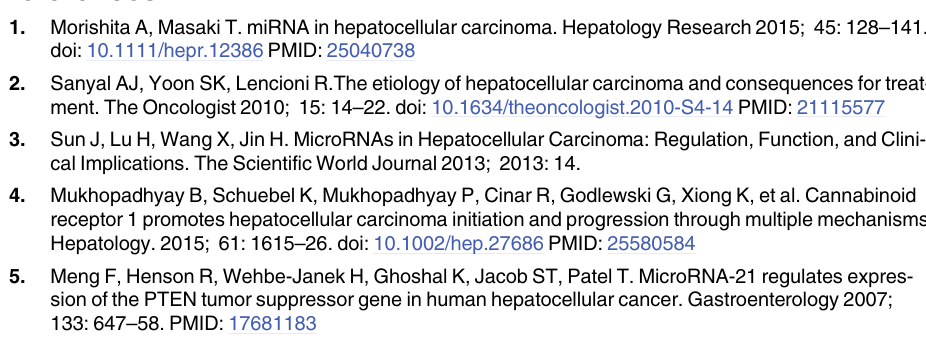
S1 Fig. Effect on cell proliferation of miR-544a. HuH-7 cells were transfected with miR-544a mimic or anti-miR-544a and their relative control molecules at 50 nM. After 48 hours, cell growth was estimated by MTT